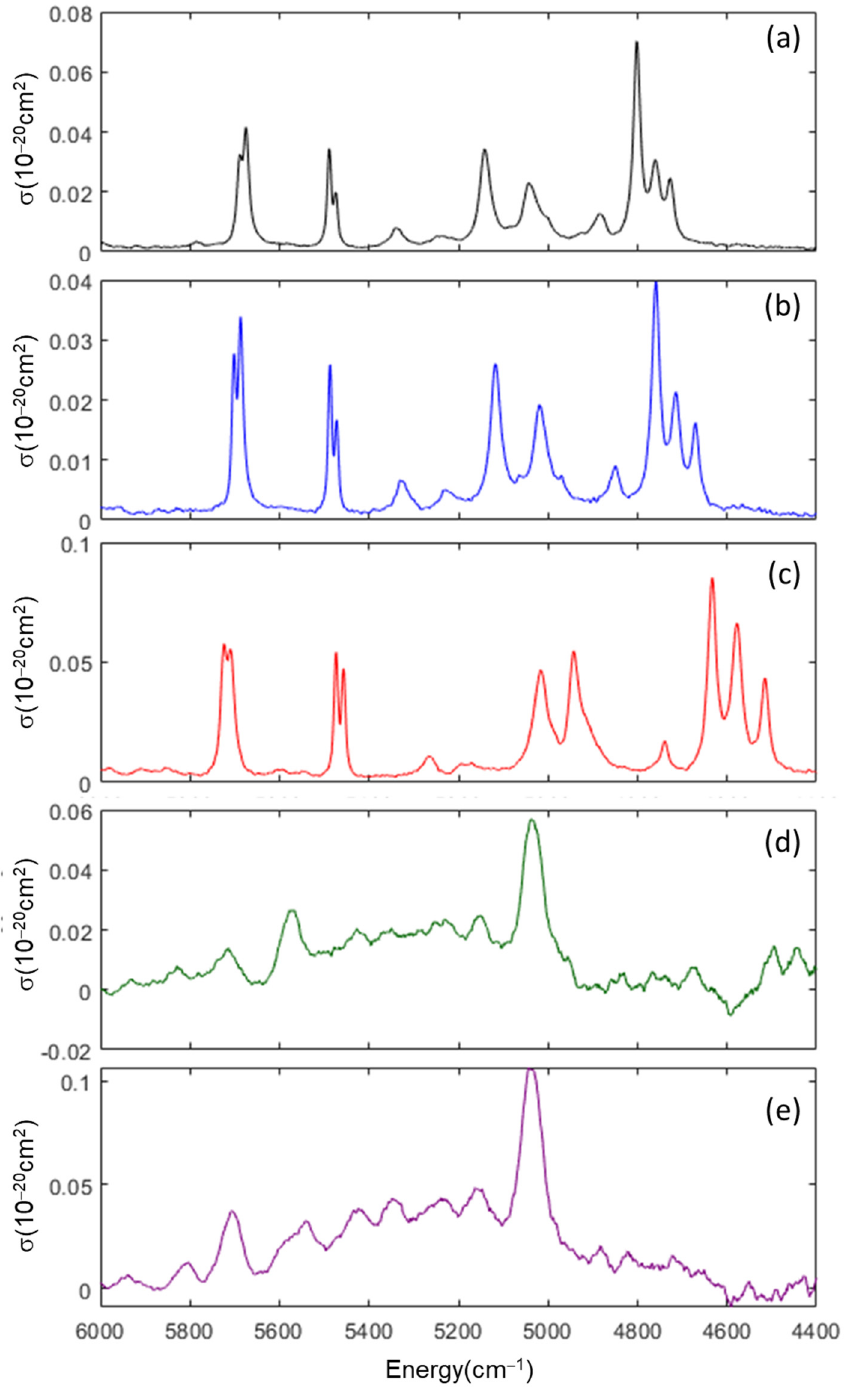
− 1 range: ( a ) 1%Nd:Y 2 O 3 ;